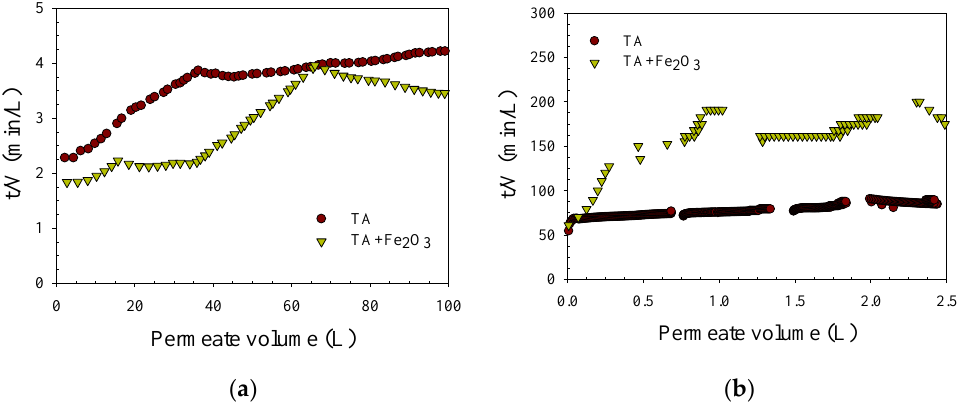
Figure 2. Reverse cumulative flux (t/V) versus permeate volume (L) at filtering tannic acid (TA) and TA + Fe 2 O 3 feed waters ( a ) MF and ( b ) UF membranes. Initial TA: 100 mg/L; initial Fe 2 O 3 : 10 mg/L; and solution pH: 7.5.